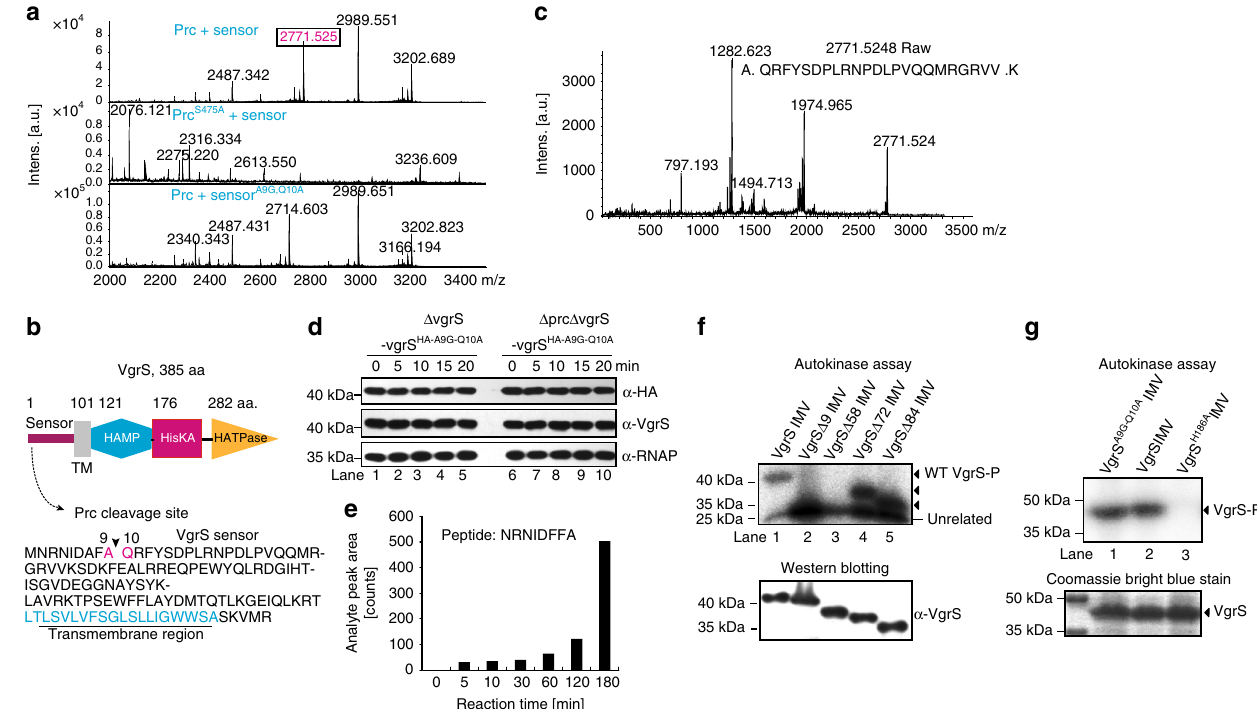
Fig. 5 Identi fi cation of the VgrS cleavage site by the Prc protease. a MALDI – TOF – MS/MS analysis revealed that Prc cleaves the VgrS sensor at the Ala 9 ↓ Gln 10 site. Upper panel: proteolysis of the VgrS sensor with active Prc. Middle panel: proteolysis of the VgrS sensor with inactive Prc S475A , which was used as a negative control. Lower panel: proteolysis of the recombinant VgrS A9G-Q10A sensor with active Prc. Digested products were detected in positive ion re fl ectron mode over an m/z range of 700 – 3500. Spectra showed relative intensities in the mass range of m/z 2000 – 3400. b Schematic view of the secondary structure of VgrS and the cleavage site in the sensor region. TM transmembrane helix. c Identi fi cation of the Prc cleavage site in the VgrS sensor. A MALDI – TOF/TOF MS/MS spectral analysis of m/z 2771.5 from a Prc + VgrS sensor sample. The magni fi ed MS/MS spectra showed the fragment patterns of peptides. d Substitution of VgrS A9G-Q10A resulted in resistance to Prc cleavage. Bacterial strains that encoded recombinant VgrS A9G- Q10A fused with an HA-tag between the 6th and 7th residues were constructed independently in the Δ vgrS and Δ vgrS Δ prc backgrounds. The bacterial strains were stimulated by 1.0 M sorbitol for different time periods. Total proteins were extracted, separated by SDS-PAGE, and analysed by western blotting. A polyclonal antibody of VgrS ( α -VgrS) was used to measure the amount of VgrS protein, while a monoclonal HA antibody ( α -HA) was used to detect the N-terminal region of VgrS that was potentially cleaved by Prc, and the polyclonal antibody of RNAP ( α -RNAP) was used as an internal control. The experiment was repeated three times. e Detection of the N-terminal short peptide of VgrS generated by Prc cleavage. Full-length VgrS embedded in inverted membrane vesicles was treated by Prc, and the proteolytic products were analysed by QTRAP LC – MS/MS at different time points. A chemically synthesized peptide, NRNIDFFA, was used as standard. Details of the QTRAP LC – MS/MS analysis are shown in Supplementary Fig. 6. f and g Deletion of the N-terminal sequence of VgrS decreased its autophosphorylation level. f An in vitro phosphorylation assay was conducted to measure the autophosphorylation levels of the truncated VgrS Δ 9 , VgrS Δ 58 , VgrS Δ 72 and VgrS Δ 84 embedded in the IMVs (10 μ M). The reaction was performed as described in Fig. 4a. g Substitution of VgrS A9G-Q10A did not affect its autokinase activity. Upper panels: autophosphorylation assay. Lower panels: western blotting of the proteins or Coomassie brilliant blue staining was used to check the amount of loaded protein. Two experimental repeats